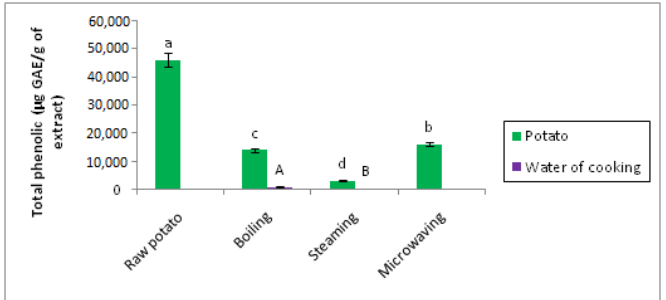
Figure 13. Effect of cooking on the total polyphenol content of potatoes. The superscript letters a, b, c, d, and e indicate a significant difference between raw and cooked potato at the 0.05 significance level. The superscript letters A, B indicate a significant difference between water of boiling and water of steaming at the 0.05 significance